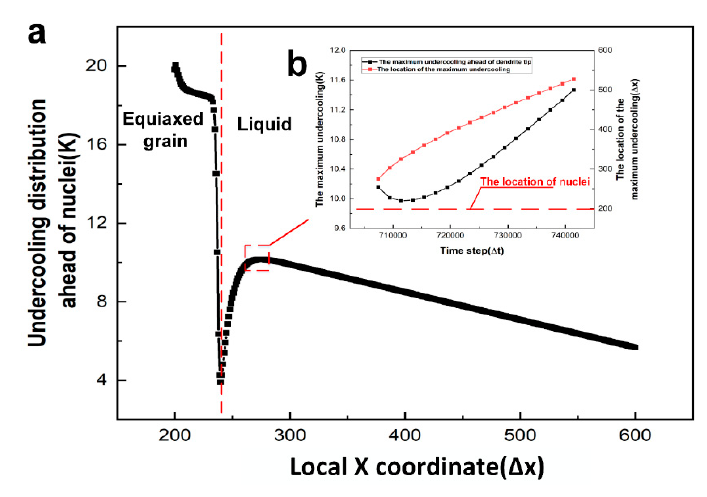
Figure 19. ( a ) The undercooling distribution ahead of nuclei; ( b ) The value and location variations of maximum undercooling in the liquid in Figure 17a with time.